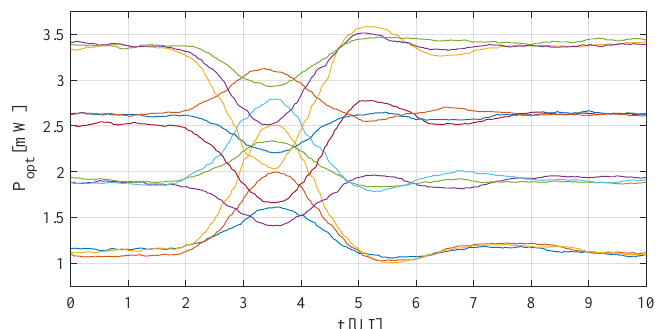
Figure 3. All 12 possible PAM-4 pulse responses at a symbol rate of